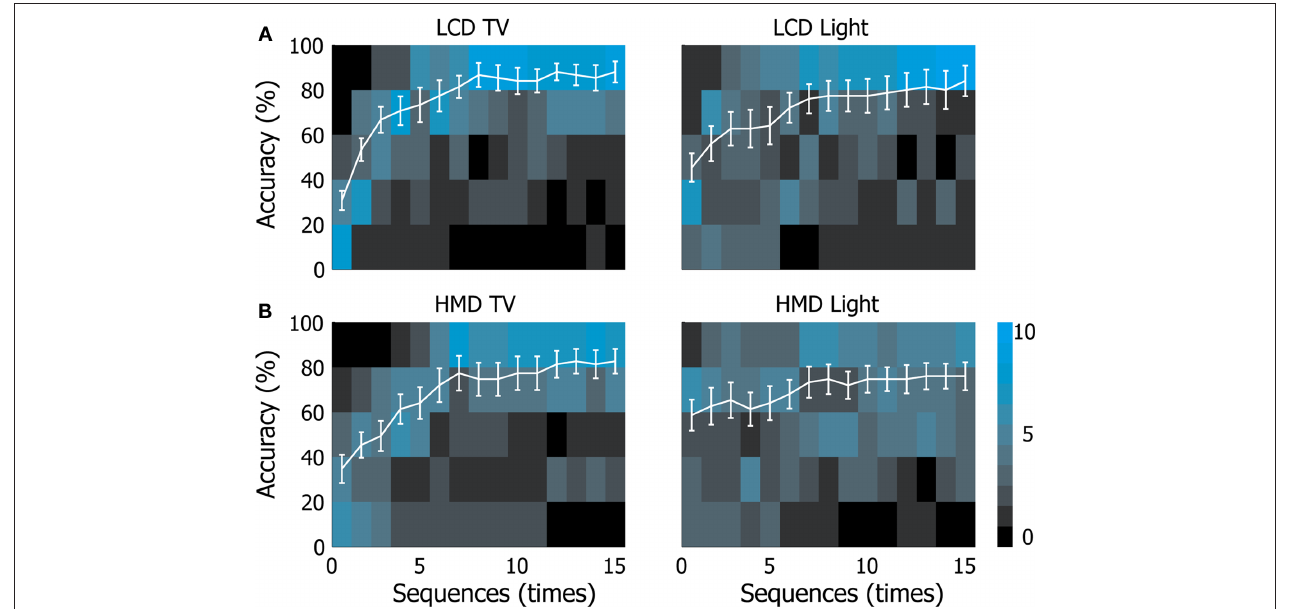
accuracy with the SE. The blue squares behind the white solid lines are two-dimensional histograms; each blue square indicates the frequency of the subjects in each sequence and their accuracy [ (A) : LCD, (B) :